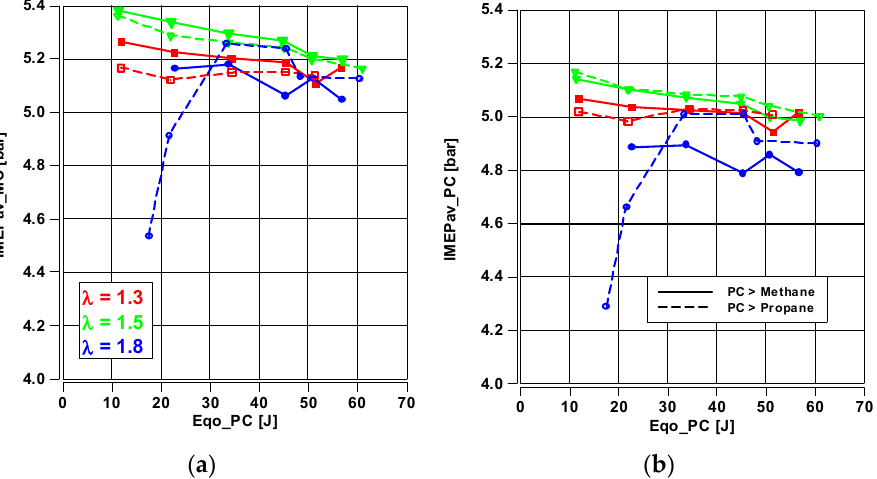
Figure 11. Variation in IMEP with respect to energy delivered to the prechamber at different values of excess air ratio λ : ( a ) variation in IMEP in the main chamber; ( b ) variation in IMEP in the prechamber.